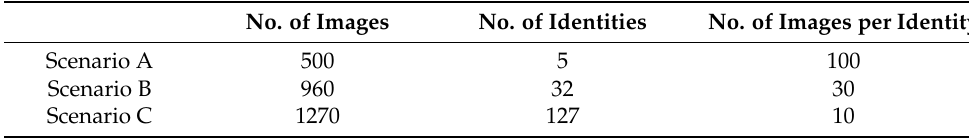
Table 7. Size of training subsets on LFW for face recognition.